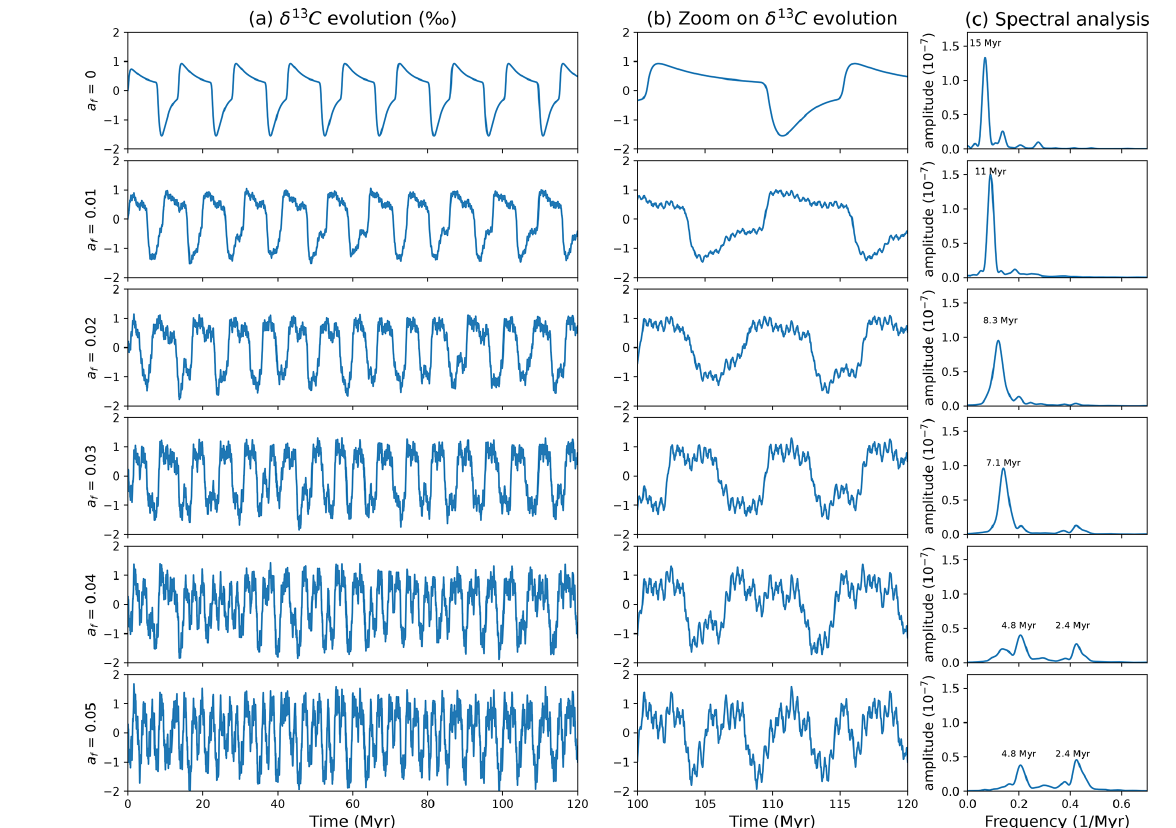
Figure 8. Case A. (a) Modelled δ 13 C for different a f values, and a = 0 . 5 · a lim . (b) Zoom on the last 20Myr of the simulation. (c) Spectral analysis of the modelled δ 13